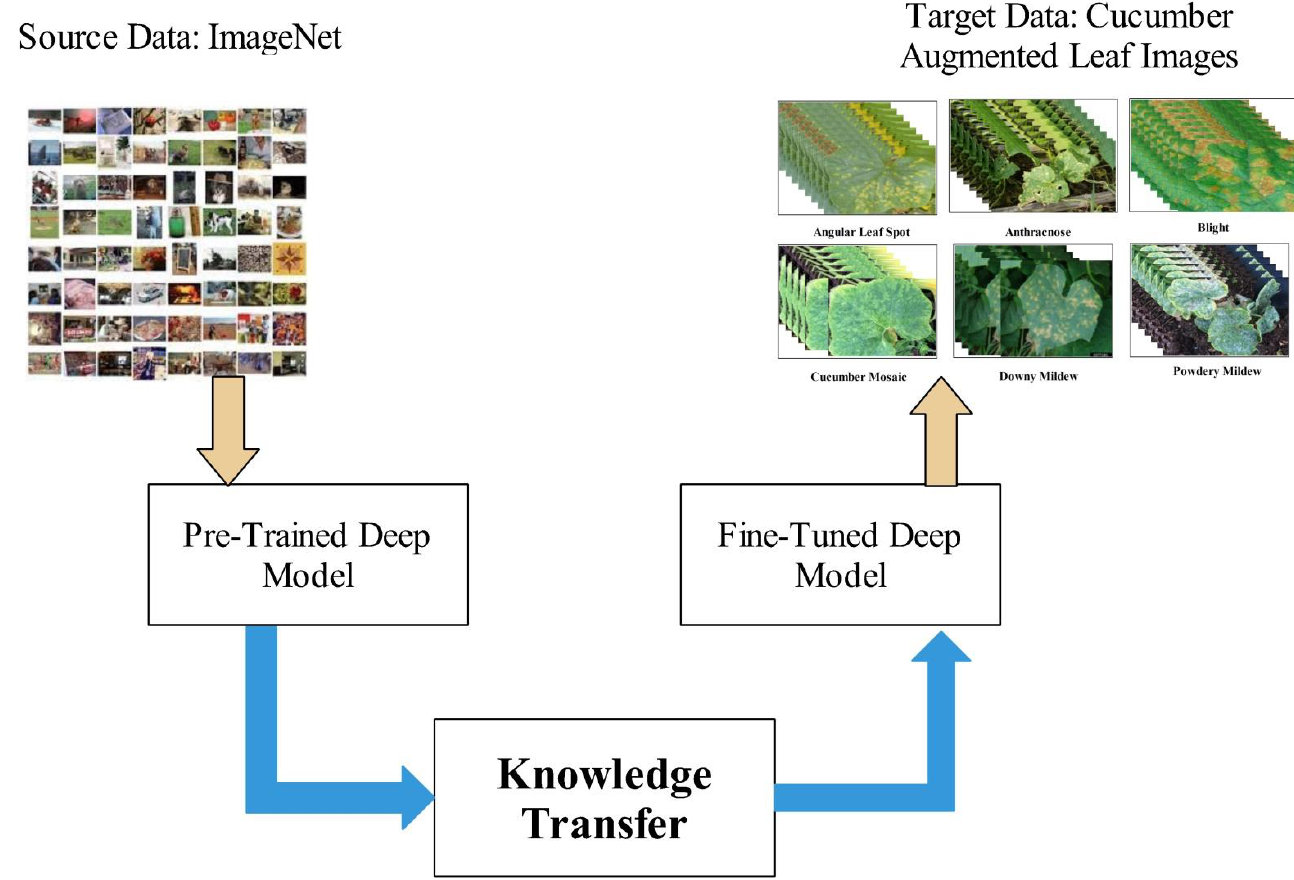
Figure 3. Transfer learning-based training of deep models for cucumber leaf diseases recognition.